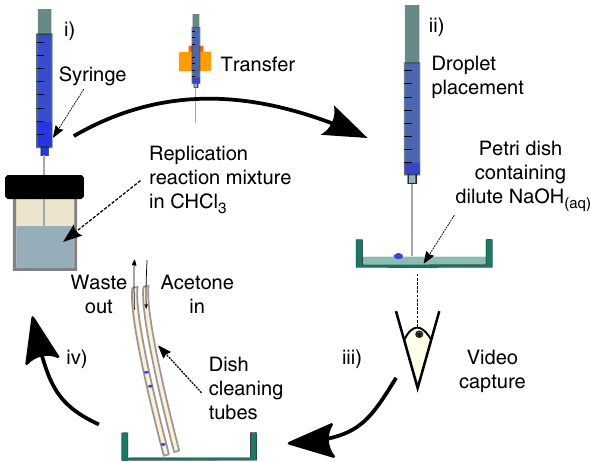
Fig. 4 Flow diagram showing the periodic droplet experiments. (i) Sampling from reaction mixtures of 10 mM 1 and 2 in chloroform. (ii) 4.0 µ l